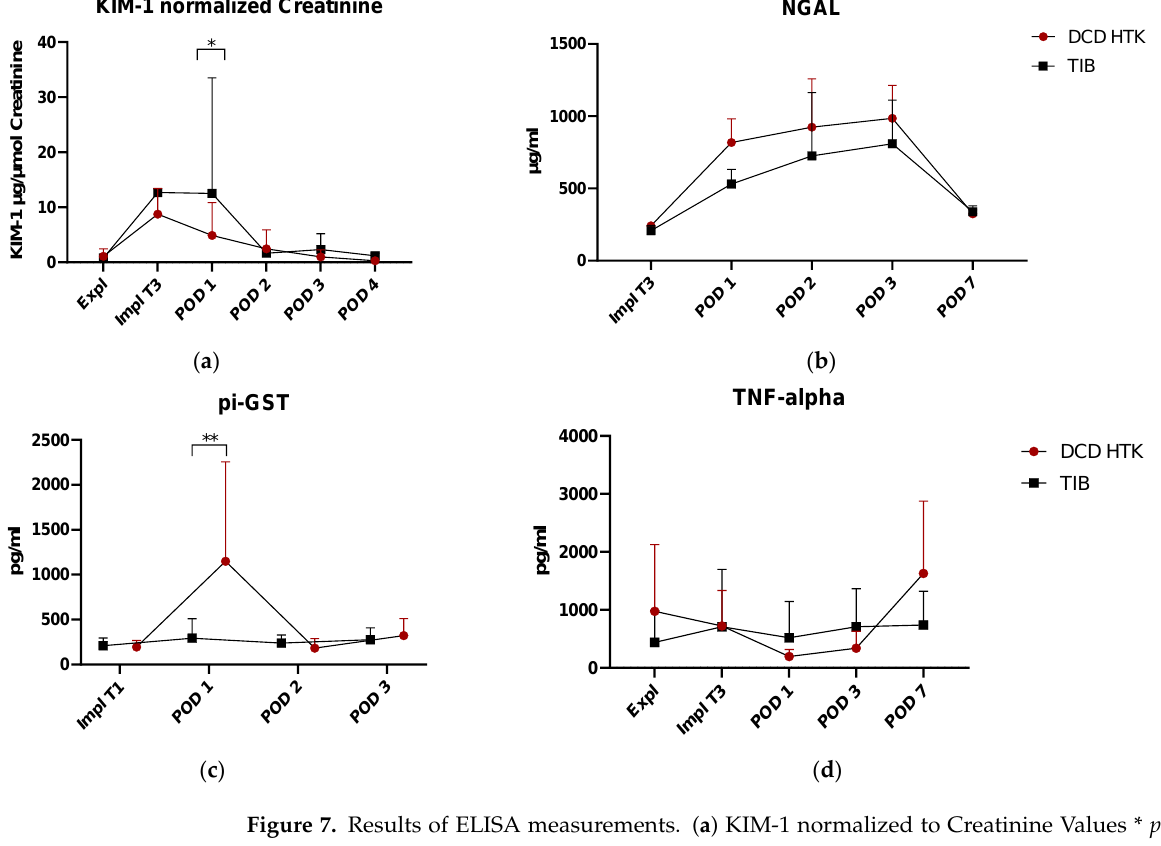
Figure 7. Results of ELISA measurements. ( a ) KIM-1 normalized to Creatinine Values * p < 0.05 (n = 4 – 6) ( b ) NGAL = Neutrophil Gelatinase Associated Lipocalin (n = 2 – 6). ( c ) pi-GST ** p < 0.01 (n = 3 – 6) ( d ) TNF-alpha values are displayed in boxplots with its median and 95% confidence intervals (n = 5 – 6) ** p < 0.01 2- Way ANOVA Sidak’s multiple comparison.